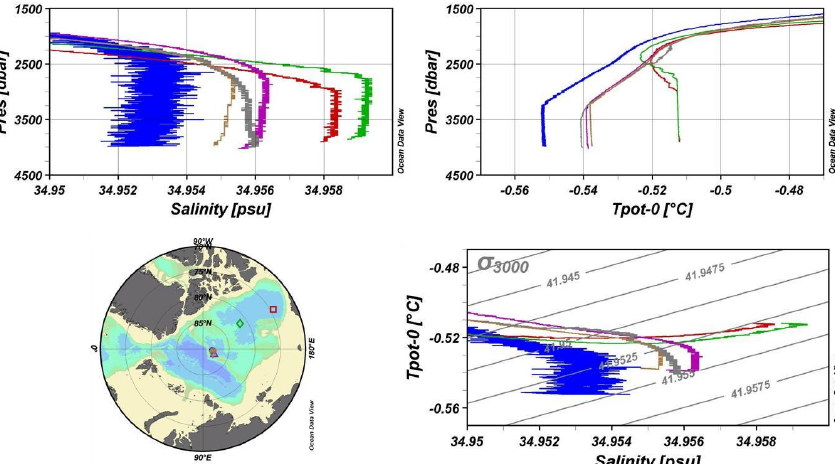
Fig. 21 . Profiles of salinity and potential temperature, and θS curves from the Makarov Basin taken in 1991 (blue station), 2001 (grey station), 2005 (magenta station) and 2007 (brown station). The green and blue stations are from the southern (red) and northern (green) taken in 2005. The deep temperature minimum is absent in the Makarov Basin, but the Makarov Basin deep water could supply the temperature minimum of the Canada Basin, which is located at the same level as the sill depth of the Alpha and Mendeleev ridges. The temperature of the Makarov Basin bottom water has increased suggesting either heating or a temporary absence of colder deep water from the Amundsen Basin spilling over the ridge that otherwise would cool the deeper layers. The salinity in the bottom layer might be increasing with time, which would require some influx of the more saline Canada Basin deep water, not just geothermal heating. However, the observed salinity increase is not continuous in time and is very close to instrumental